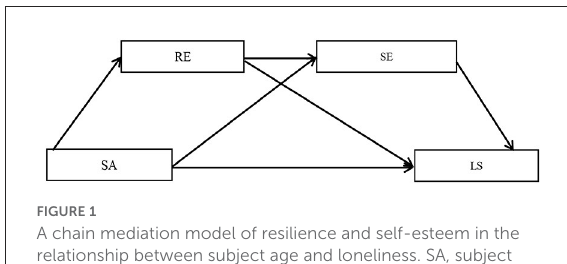
FIGURE1 A chain mediation model of resilience and self-esteem in the relationship between subject age and loneliness. SA, subject age; LS, loneliness; RE, resilience; SE,